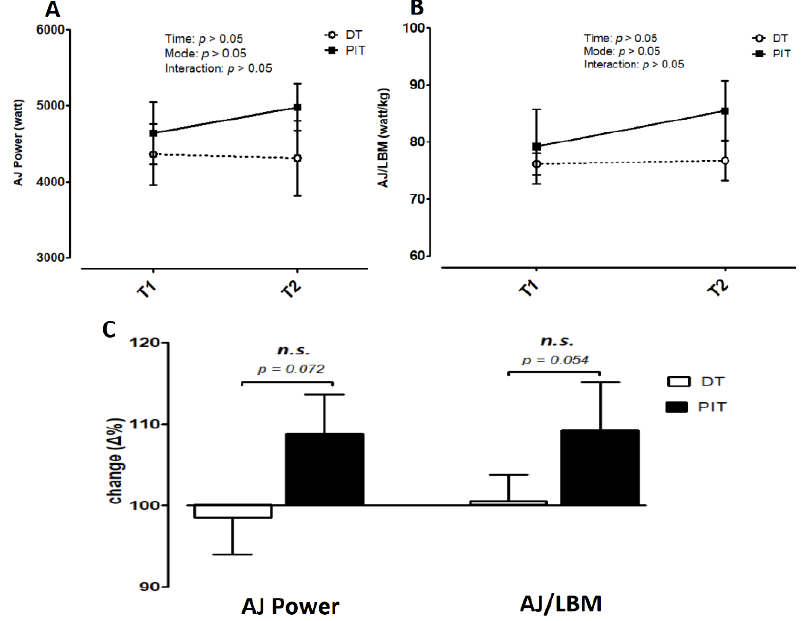
Figure 5. Abalakov jump (AJ) and AJ/lean body mass (LBM). ( A ) AJ and ( B ) AJ/LBM were meas- ured in pre-test (T1) and post-test (T2). The rates of AJ and AJ/LBM change from T1 to T2 are dis- played ( C ). Data are expressed as mean ±